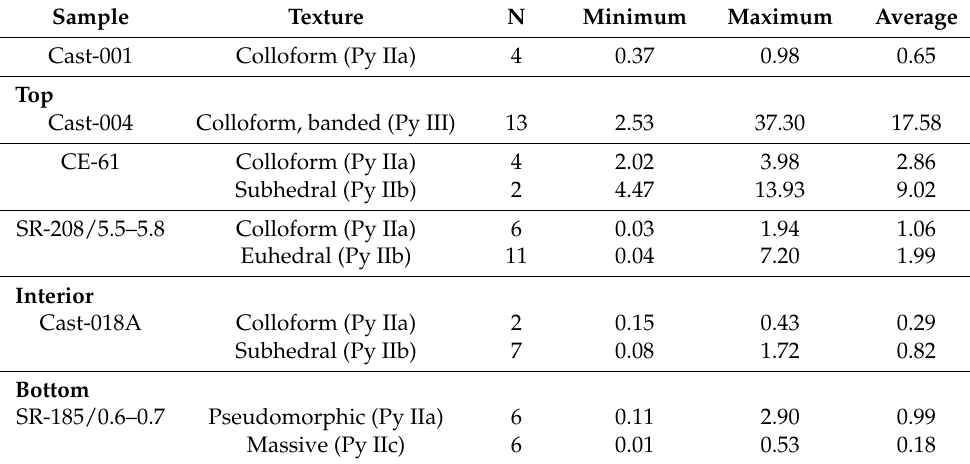
Table 1. Gold contents (ppm) in different textural types of